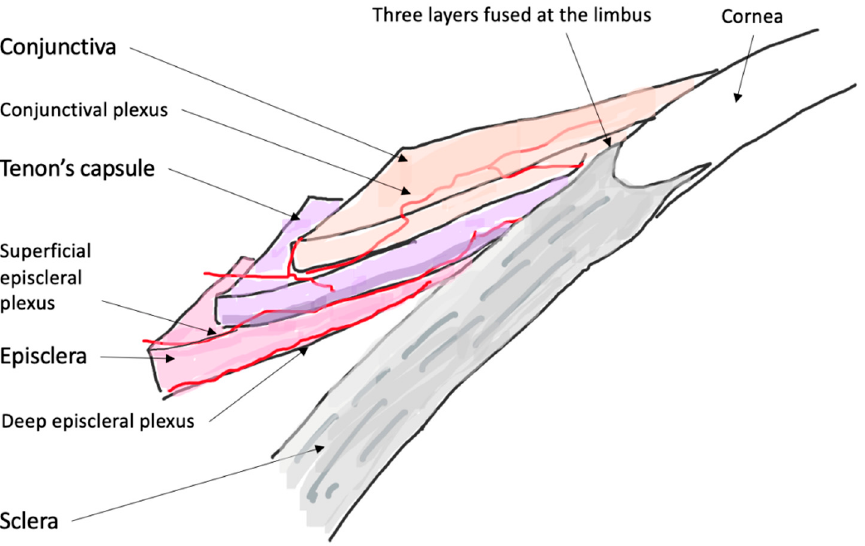
Figure 1. Cross sectional diagram of the normal anatomy of the outer layers of the eye. The most superficial layer is the conjunctiva with the conjunctival vascular plexus, easily moved over the underlying structures. Underneath, the Tenon’s capsule and the episclera, with an episcleral plexus of straight, radially arranged vessels. The deepest is the scleral plexus, tightly adherent to the sclera.